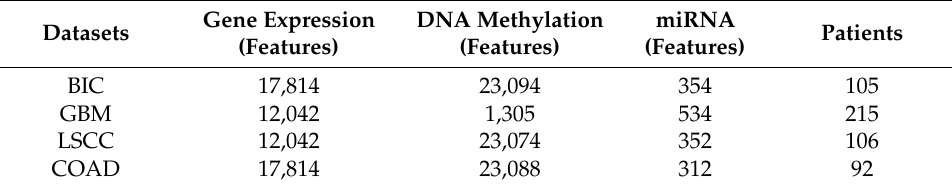
Table 1. Statistics of datasets for four cancer types used in this